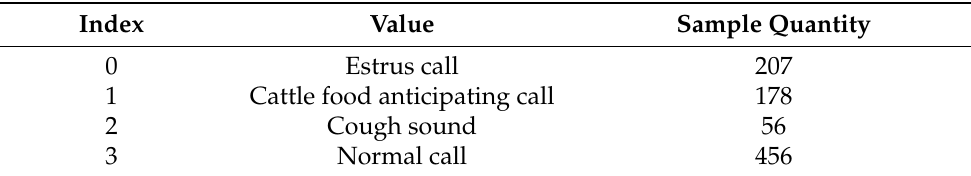
Table 2. Categories of animal sounds ( n classes for cattle).